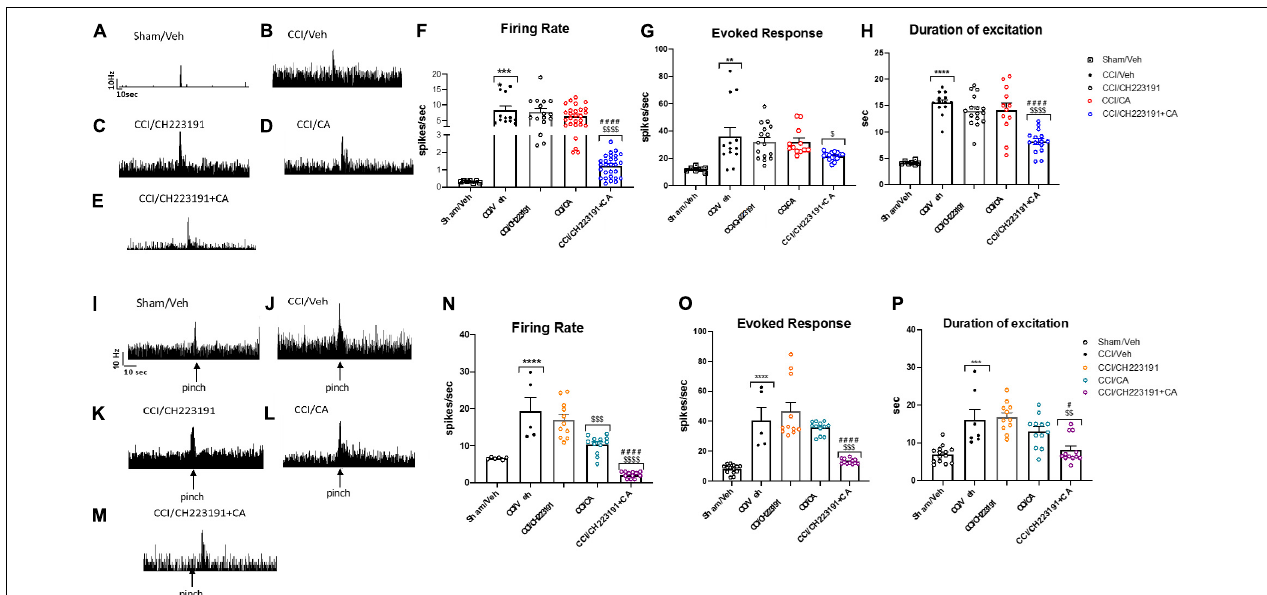
FIGURE 7 | Spinal NS neurons and RVM ON cell hyperexcitability is significantly attenuated by repeated administration of CA in combination with CH223191, in WT CCI mice. (A–E) Representative ratemeters showing spontaneous and noxious-evoked activity of spinal NS neurons in Sham mice (A) or in CCI mice before and after treatment with vehicle (B) , CH223191 (C) , CA (0.25 mg/Kg) (D) , CH223191+CA (E). (F–H) Mean ± S.E.M population data of systemic repeated administrations of CH223191 (1 mg/Kg) in presence of cinnabarinic acid (CA, 0.25 mg/Kg) on firing rate (F) , evoked response (G) and duration of excitation (H) of spinal NS neurons, in CCI mice (I–M) representative ratemeters showing spontaneous and noxious-evoked activity of RVM ON cell in Sham mice (I) or in CCI mice before and after treatment with vehicle (J) , CH223191 (K) , CA (0.25 mg/Kg) (L) , CH223191+CA (M) . (N–P) Mean ± S.E.M population data of systemic repeated administrations of CH223191 (1 mg/Kg) in presence of cinnabarinic acid (CA, 0.25 mg/Kg) on firing rate (N) , evoked response (O) and duration of excitation (P) of RVM ON cell, in CCI mice. Each point represents the mean of five different mice per group (one neuron recorded per each mouse). ** p < 0.01, *** p < 0.001 and **** p < 0.0001 indicate statistically significant difference vs. Sham/Veh, $ p < 0.05, $$ p < 0.01, $$$ p < 0.001 and $$$$ p < 0.0001 indicate statistically significant difference vs. CCI/CH223191, # p < 0.05 and #### p < 0.0001 indicate statistically significant difference vs. CCI/CA. One-way ANOVA followed by Tukey’s post-hoc test for multiple comparisons was